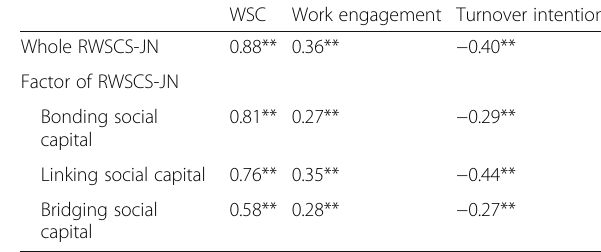
Table 5 Correlation between the RWSCS-JN score and